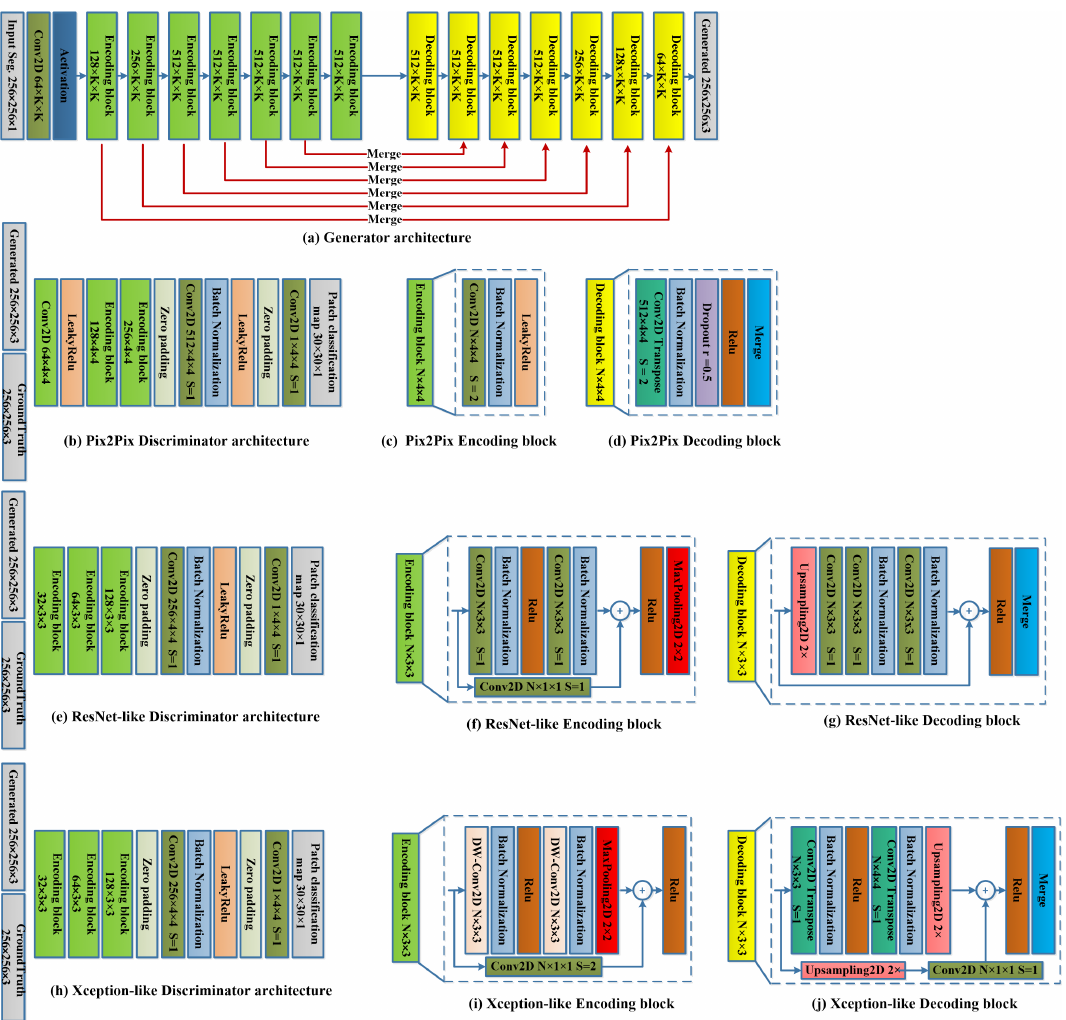
Figure 2. The proposed architectures of generators and